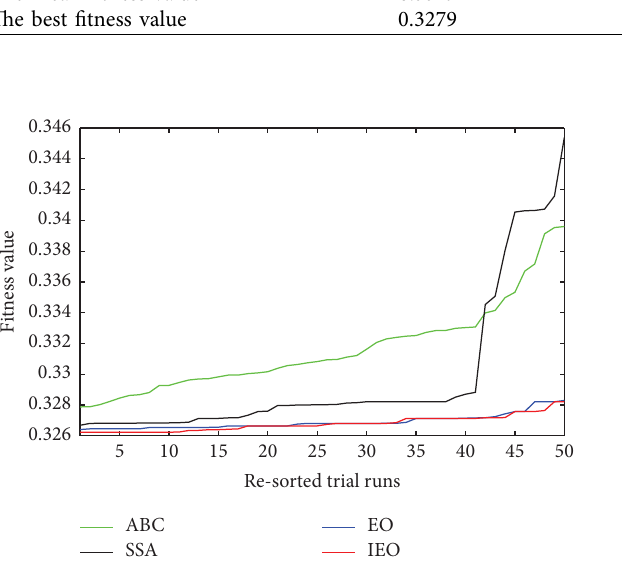
Figure 12: Te ftness values of 50 trial runs in increasing ar- rangement for the IEEE 69-bus